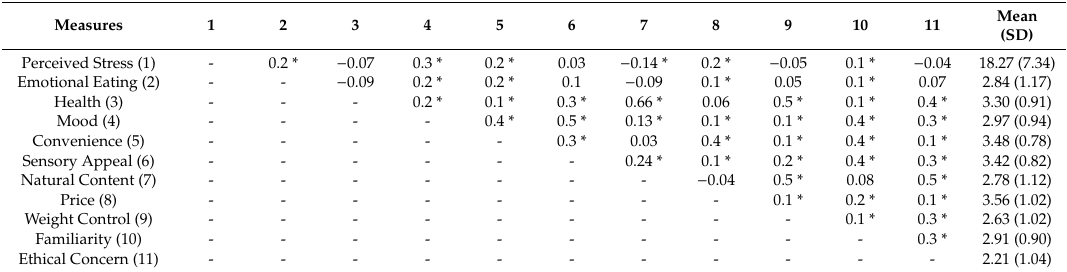
Table 2. Correlations for all outcome measured.